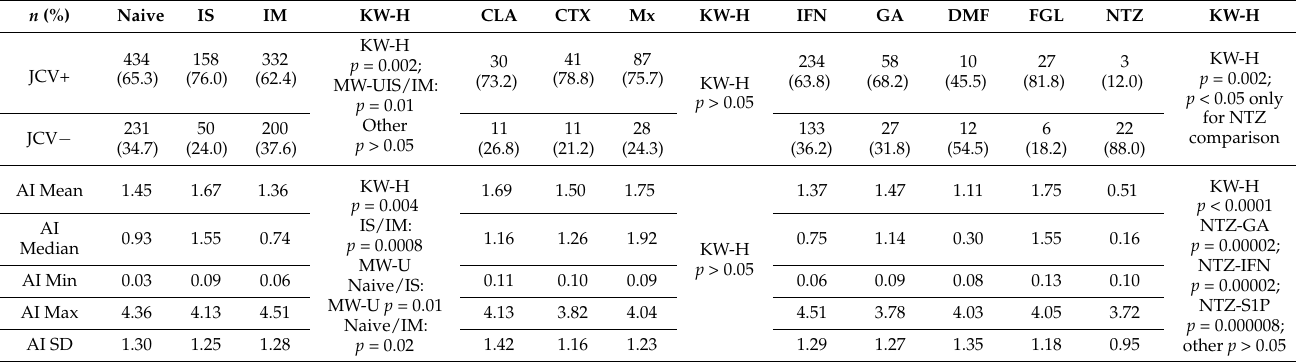
Table 4. Anti-JCV Ab prevalence and antibody index by patients’